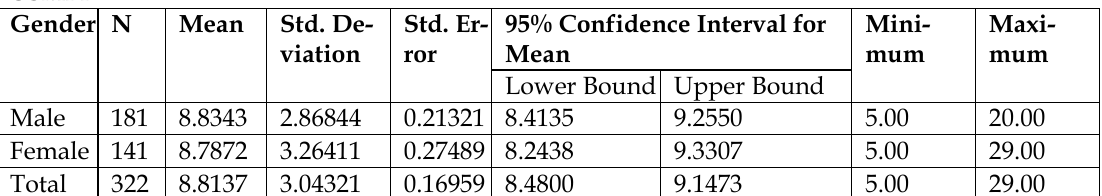
Table 8b: One-way ANOVA test for gender Descriptive